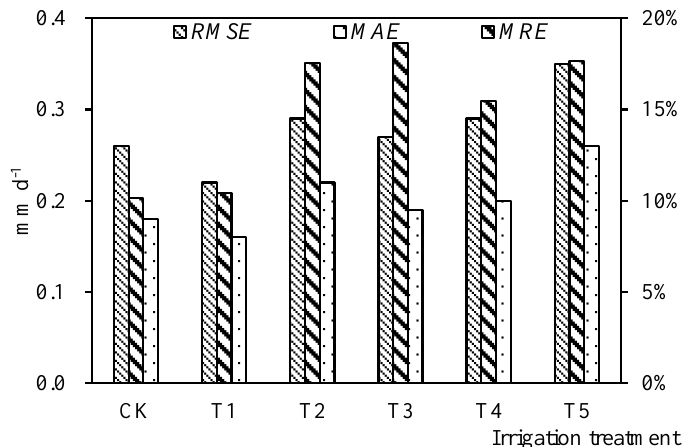
Figure 9. Root mean square error ( RMSE ; mm d − 1 ), mean absolute error ( MAE ; mm d − 1 ) and mean relative error ( MRE ; %) of estimated winter wheat evapotranspiration using the crop coefficients optimized by the genetic algorithm during the whole growth period for different irrigation treatments. CK: full irrigation treatment; T1–T5: deficit irrigation treatments.